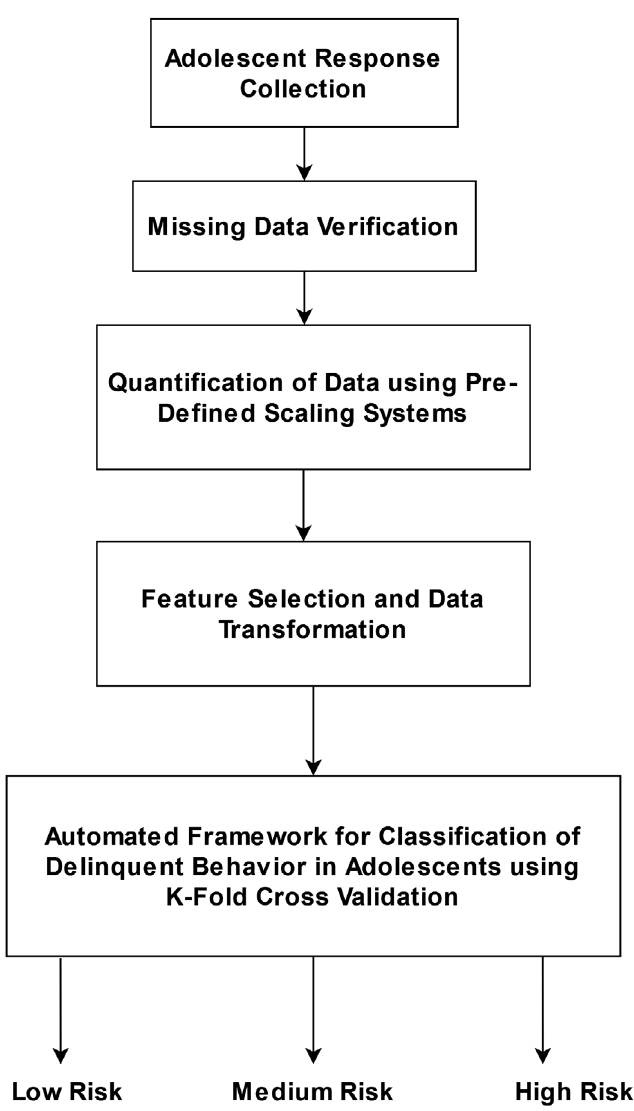
Fig. 2 The overall step-by-step computational approach for the early diagnosis of delinquent behavior in juveniles. The developed model can classify adolescent behavior into three classes, i.e., low, medium, and